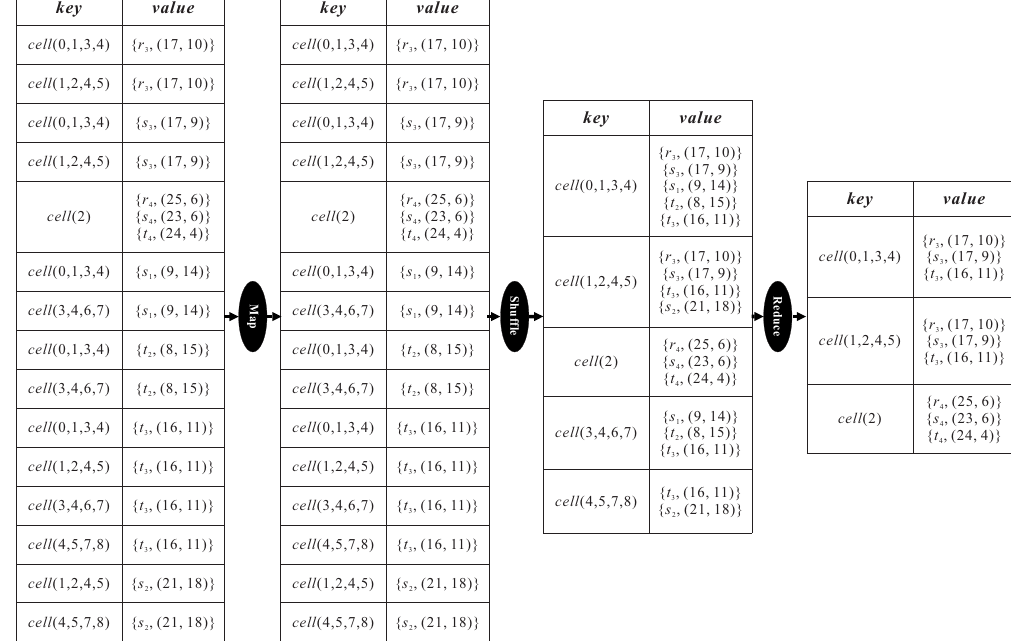
Figure 5. Illustration of the Outer HNO set determining